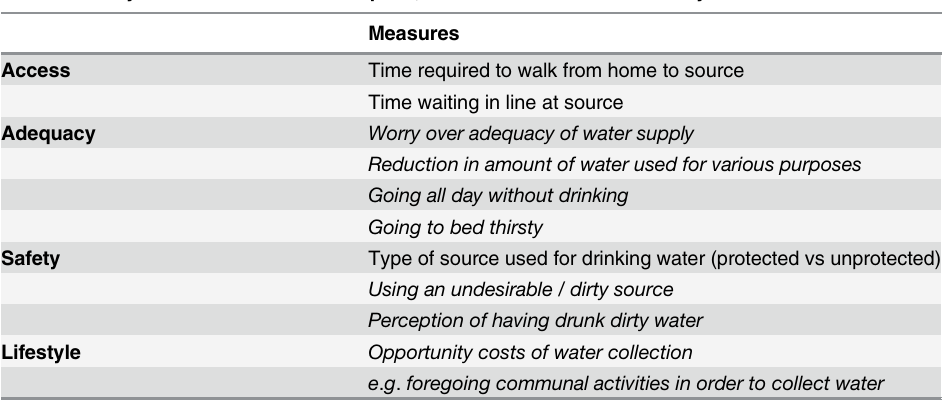
Table 1. Measures of water insecurity employed in this study. Water security: "reliable access to adequate, safe water for an active